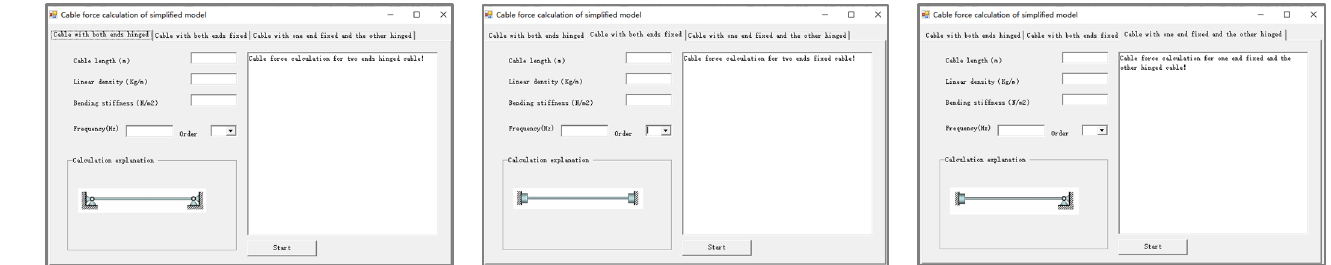
Figure 20. Cable force calculation in the simplified model.